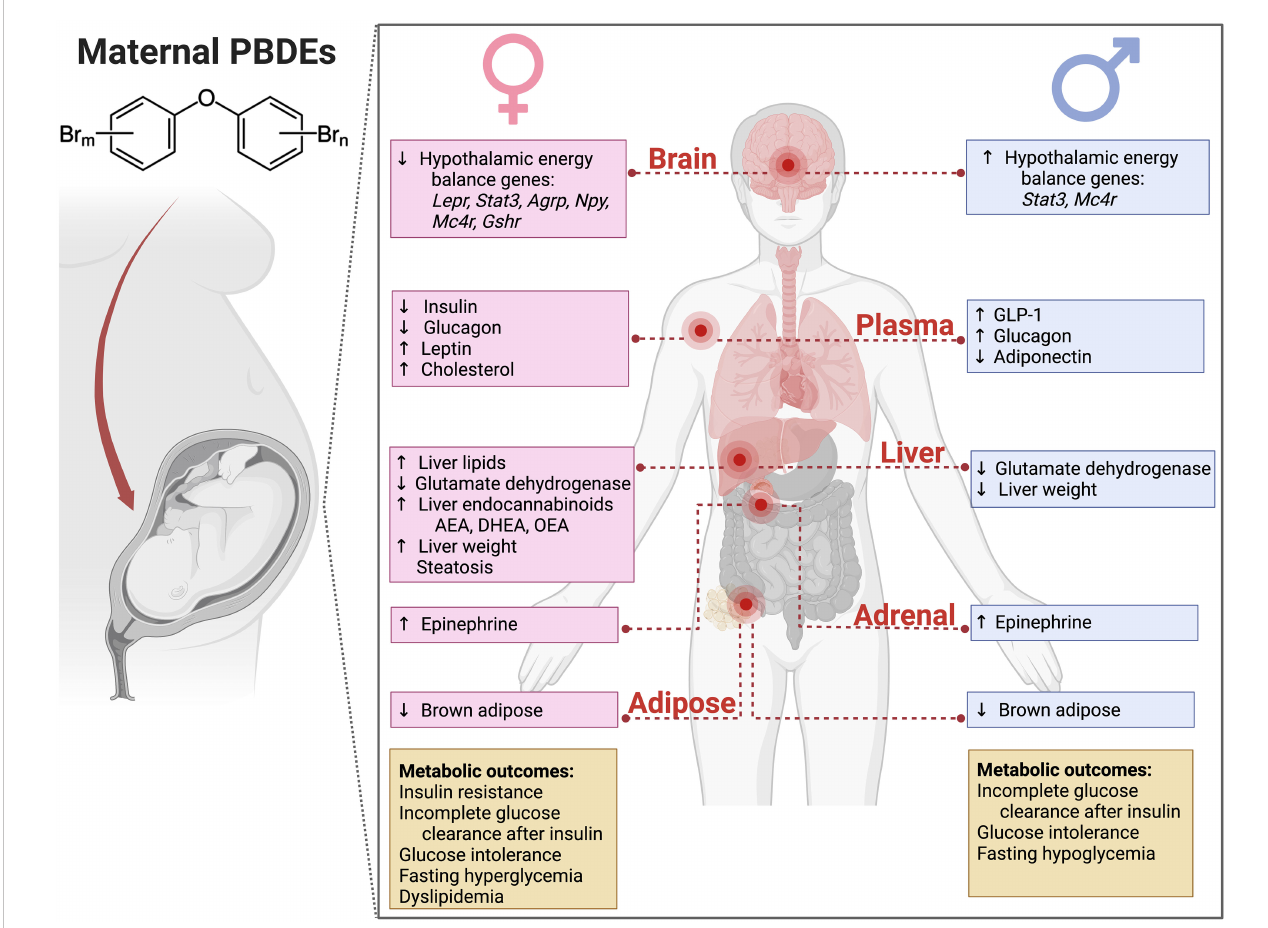
FIGURE 9 Summary of physiological consequences in adulthood of developmental exposure to PBDEs in DE-71 (0.1 and 0.4 mg/kg/d, GD0-PND21). Maternal DE- 71 exposure produces sex-dependent differences in adult mice offspring. Offspring were exposed to DE-71 via the dam during the in utero and lactational period. Adult offspring were evaluated using in vivo glucose and insulin responses and ex vivo tissue analyses. The glucoregulation results obtained from exposure female offspring and lipid metrics measured in exposed female and male offspring have been previously reported (28,